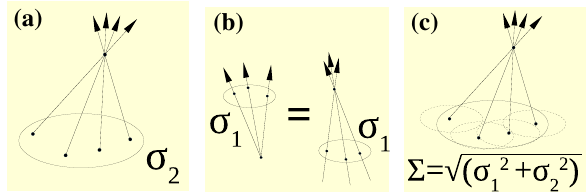
Fig. 3 Theforcebetweenthebunchesdoesnotchangewhenonebunch density ρ i ( r ) ( i = 1 , 2) is collapsed to the point charge at the origin whiletheotherisconvolvedwith ρ i ( − r ) .FortheGaussian ρ 1 , 2 densities the convolution has sigma (cid:10) =